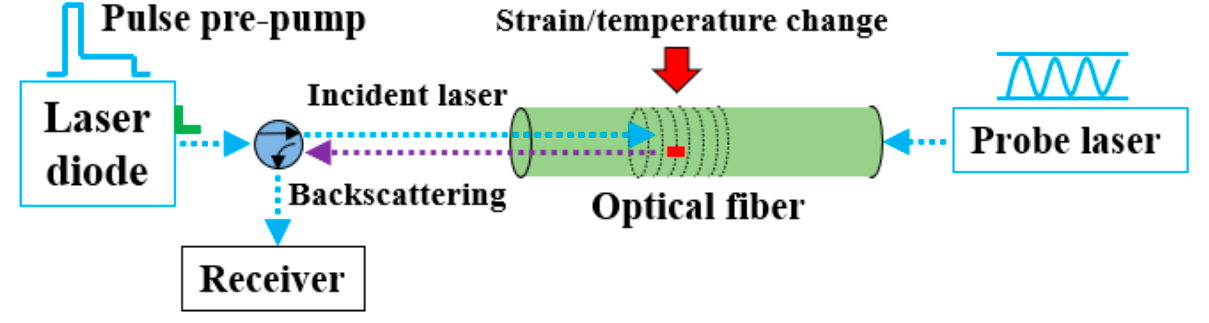
Figure 3. PPP-BOTDA working principle.